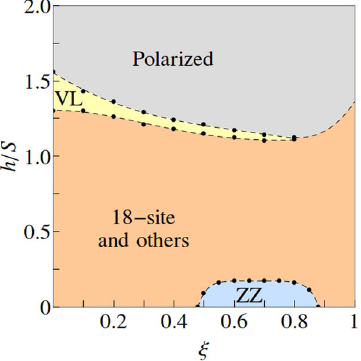
Fig. 10 Towards realistic models. We continuously deform the dual model of the K Γ model with K > 0 and Γ < 0 to models that are relevant to α -RuCl 3 and similar materials, by tuning ξ from 0 to 1. We fi nd a signi fi cant extent of the classical magnetic vortex liquid to large values of ξ , where the ground state in the low- fi eld regime is the ZZ